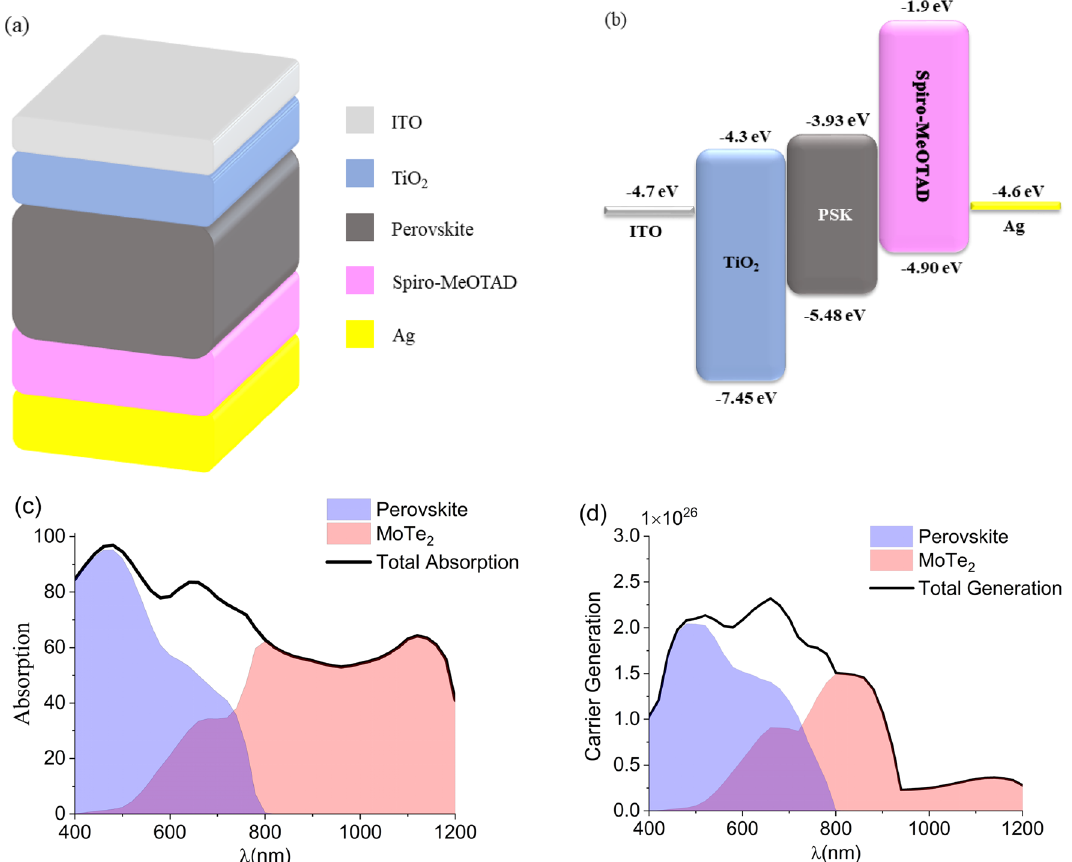
Figure 1. Schematic and energy diagram and device performance. ( a ) The stack structure of the basic PSC designed in this work. ( b ) the band alignment diagram and operation principle of the basic PSC. ( c ) The absorption spectra of the basic PSC, with determining the contribution of each layer. ( d ) the carrier generation rate in absorbing layers as a function of